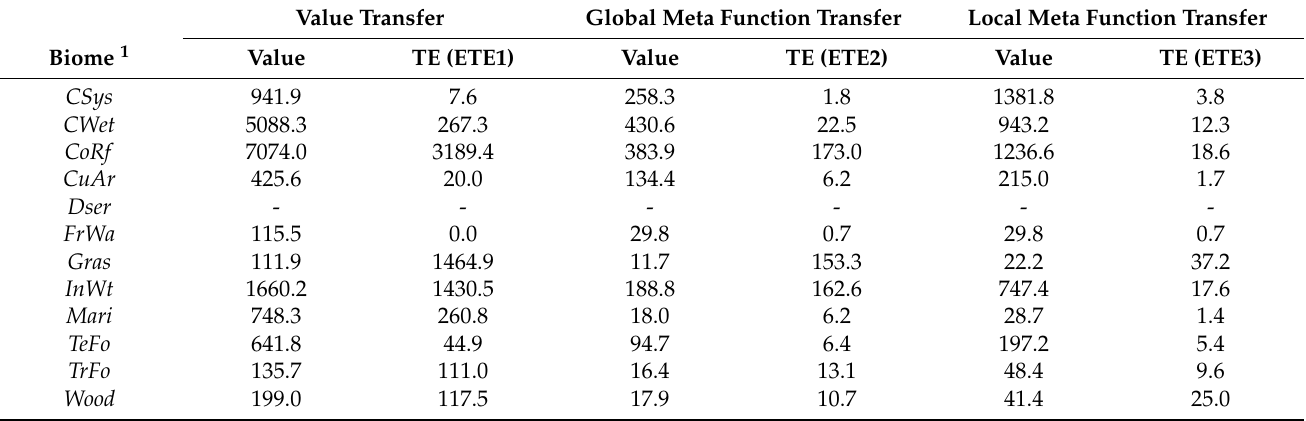
Table 7. Comparison of values and transfer errors (TE) per biome for Regulating and maintenance ES, based on Value transfer, Global meta function transfer, and Local meta function transfer (in 2015 €